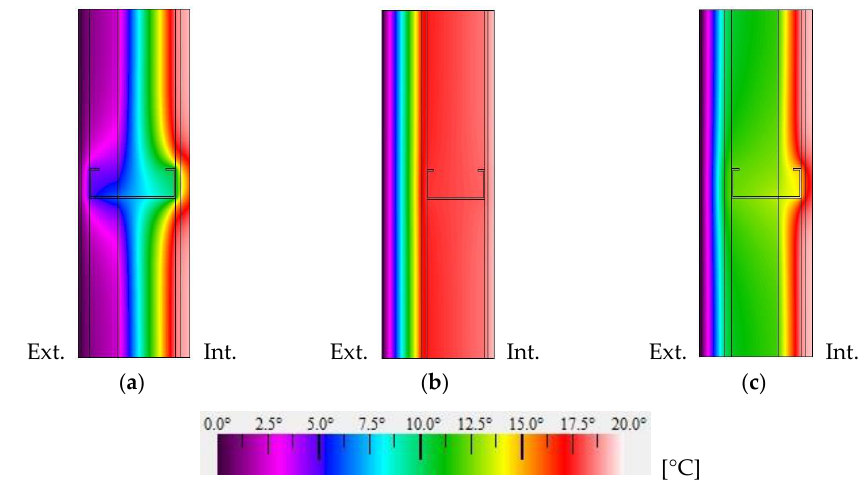
Figure 2. Temperature distribution in LSF facade walls: ( a ) cold frame construction (U = 0.5316 Temperature distribution in LSF facade walls: ( a ) cold frame construction W·m −2 ·K −1 ); ( b ) warm frame construction (U = 0.2951 W·m −2 ·K −1 ); and ( c ) hybrid frame construction (U (U = 0.5316 W · m − 2 · K − 1 ); ( b ) warm frame construction (U = 0.2951 W · m − 2 · K − 1 ); and ( c ) = 0.3581 W·m −2 ·K −1 ).